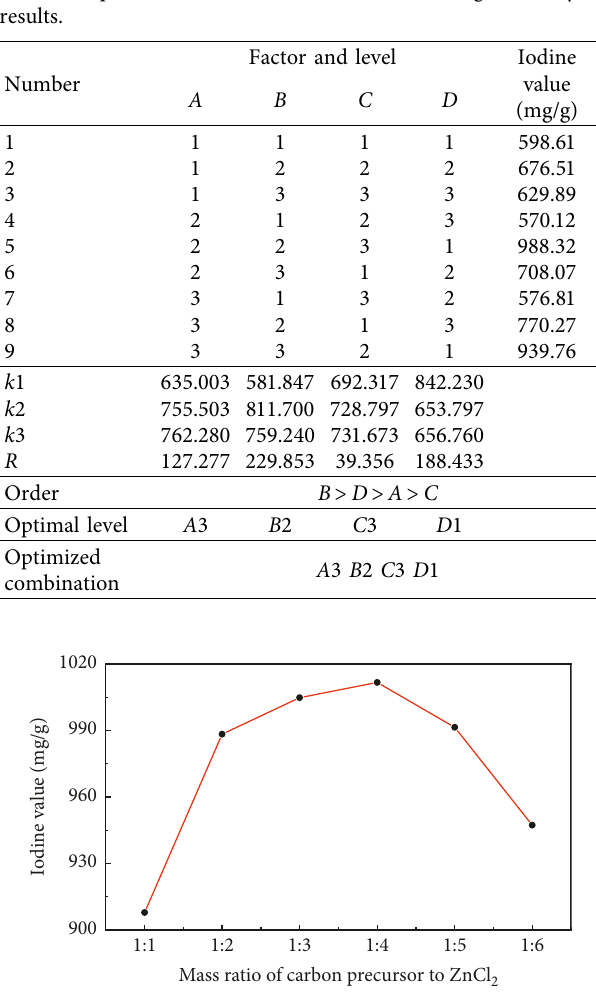
Figure 1: The influence of the mass ratio of the carbon precursor to ZnCl 2 on the iodine value of sludge carbon.